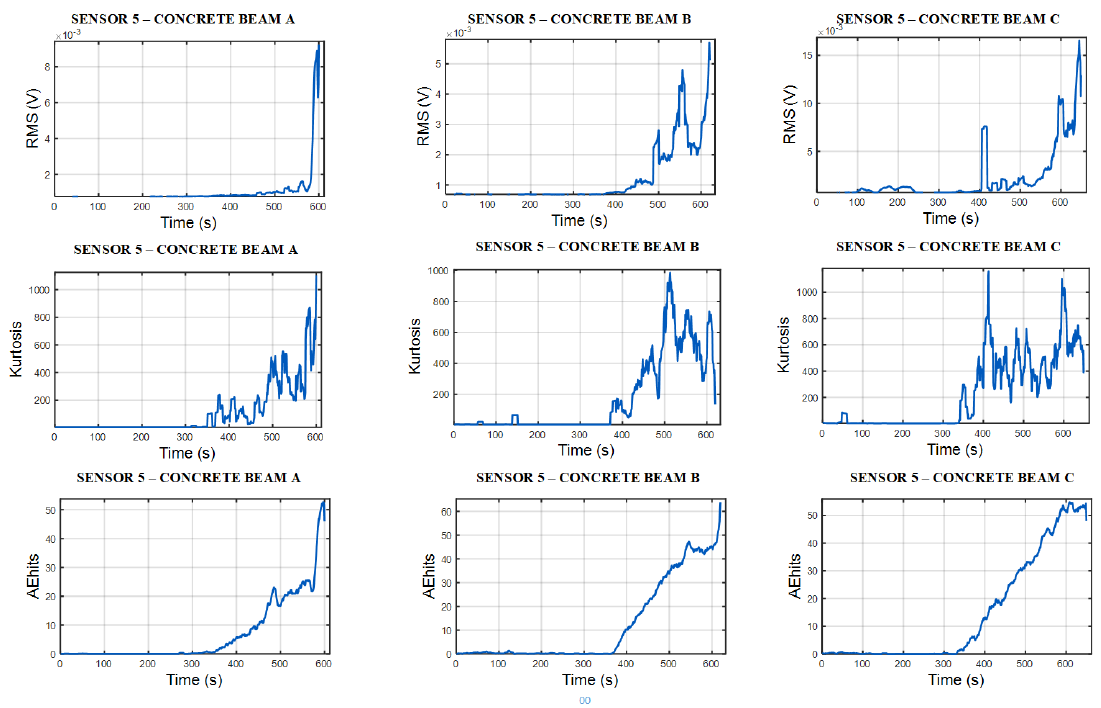
Figure 10. Illustration of the degradation process of concrete beams using RMS values, kurtosis values and AE hits.